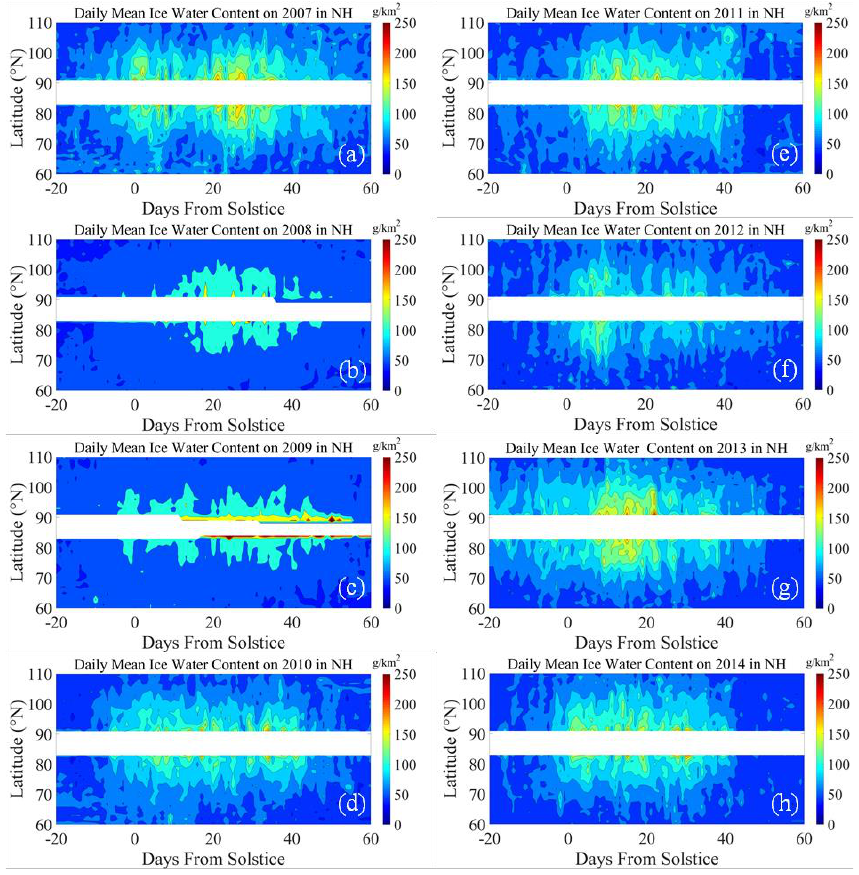
Figure 3. The distribution of daily averaged IWC during the PMC seasons from 2007 to 2014 in NH. (a) IWC on 2007 PMC season; (b) IWC on 2008 PMC season; (c) IWC on 2009 PMC season; (d) IWC on 2010 PMC season; (e) IWC on 2011 PMC season; (f) IWC on 2012 PMC season; (g) IWC on 2013 PMC season; (h) IWC on 2014 PMC season.